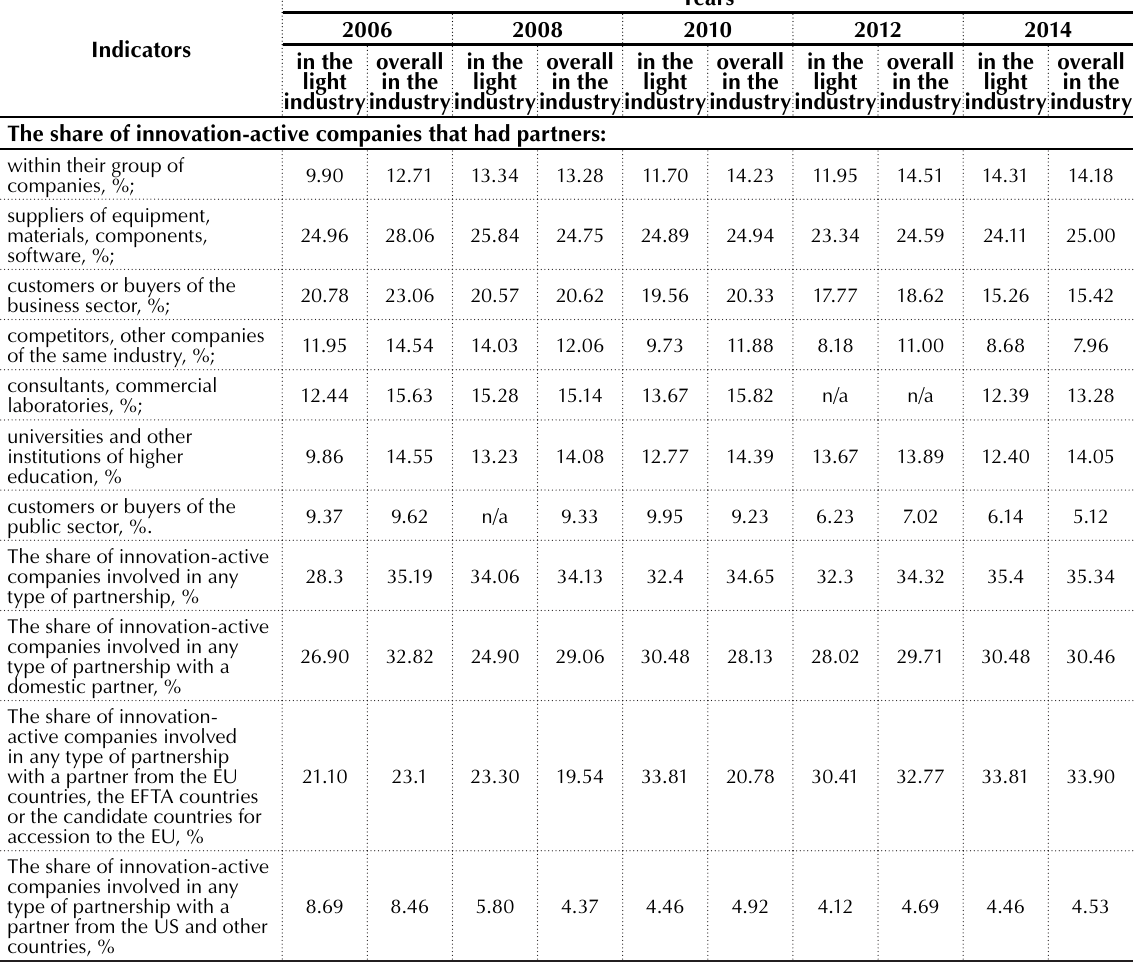
Source: Eurostat (2018). Years in the overall in the overall in the overall in the overall in the overall light in the light in the light in the light in the light in the industry industry industry industry industry industry industry industry industry industry